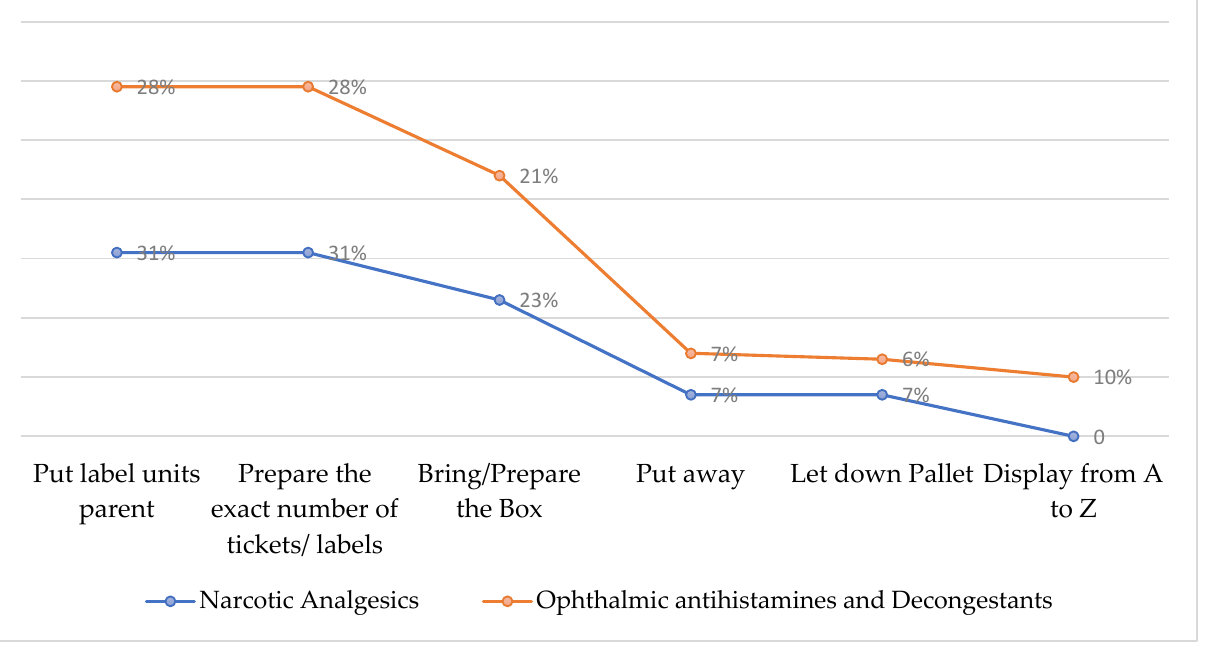
Figure 7. A comparison between vital VAS (20% of Pareto analysis) of ophthalmic antihistamines and decongestants and narcotic analgesics.